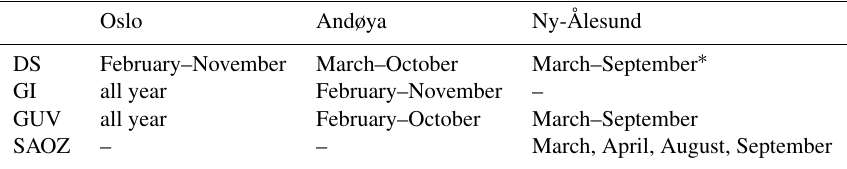
Table 1. Data availability of all instruments used for the combined total ozone time series at the three